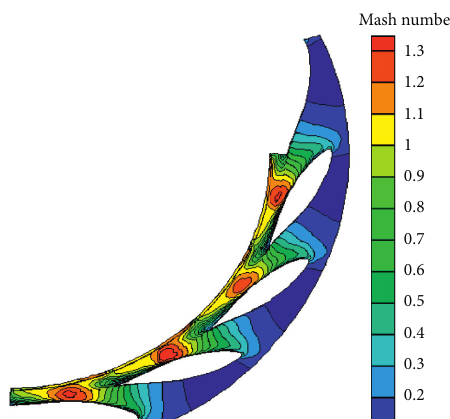
Figure 19: Opening 0 ° .